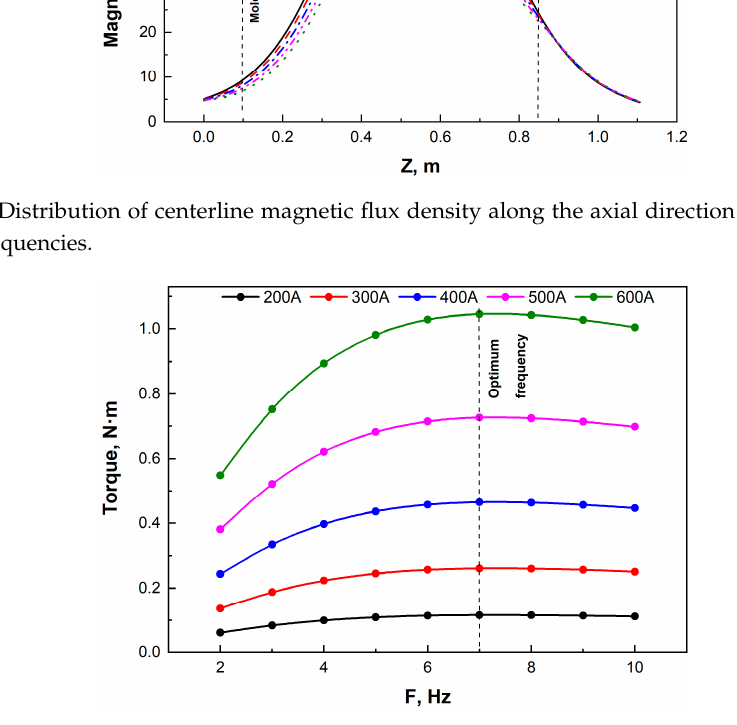
Figure 10. Electromagnetic torque of strand under different current intensities and frequencies.